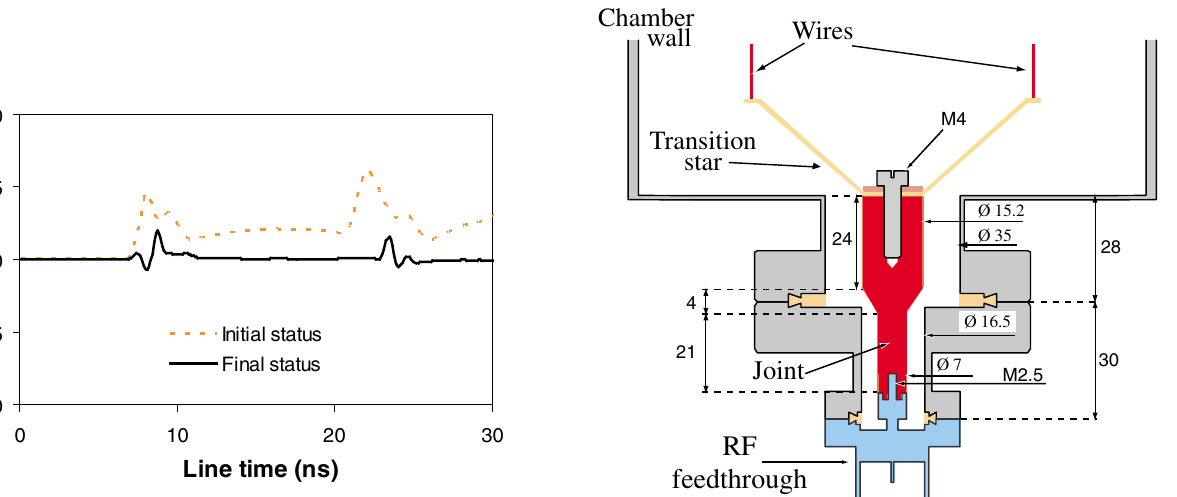
one gets Z along the transmission line, as shown in line Fig. 7. Ideally, the characteristic impedance should be 50 (cid:3) all along the path in order to avoid reflections. The orange segments (original status) indicate that there are impedance mismatches at the feedthrough locations as well as along the wire (a minor effect). The two